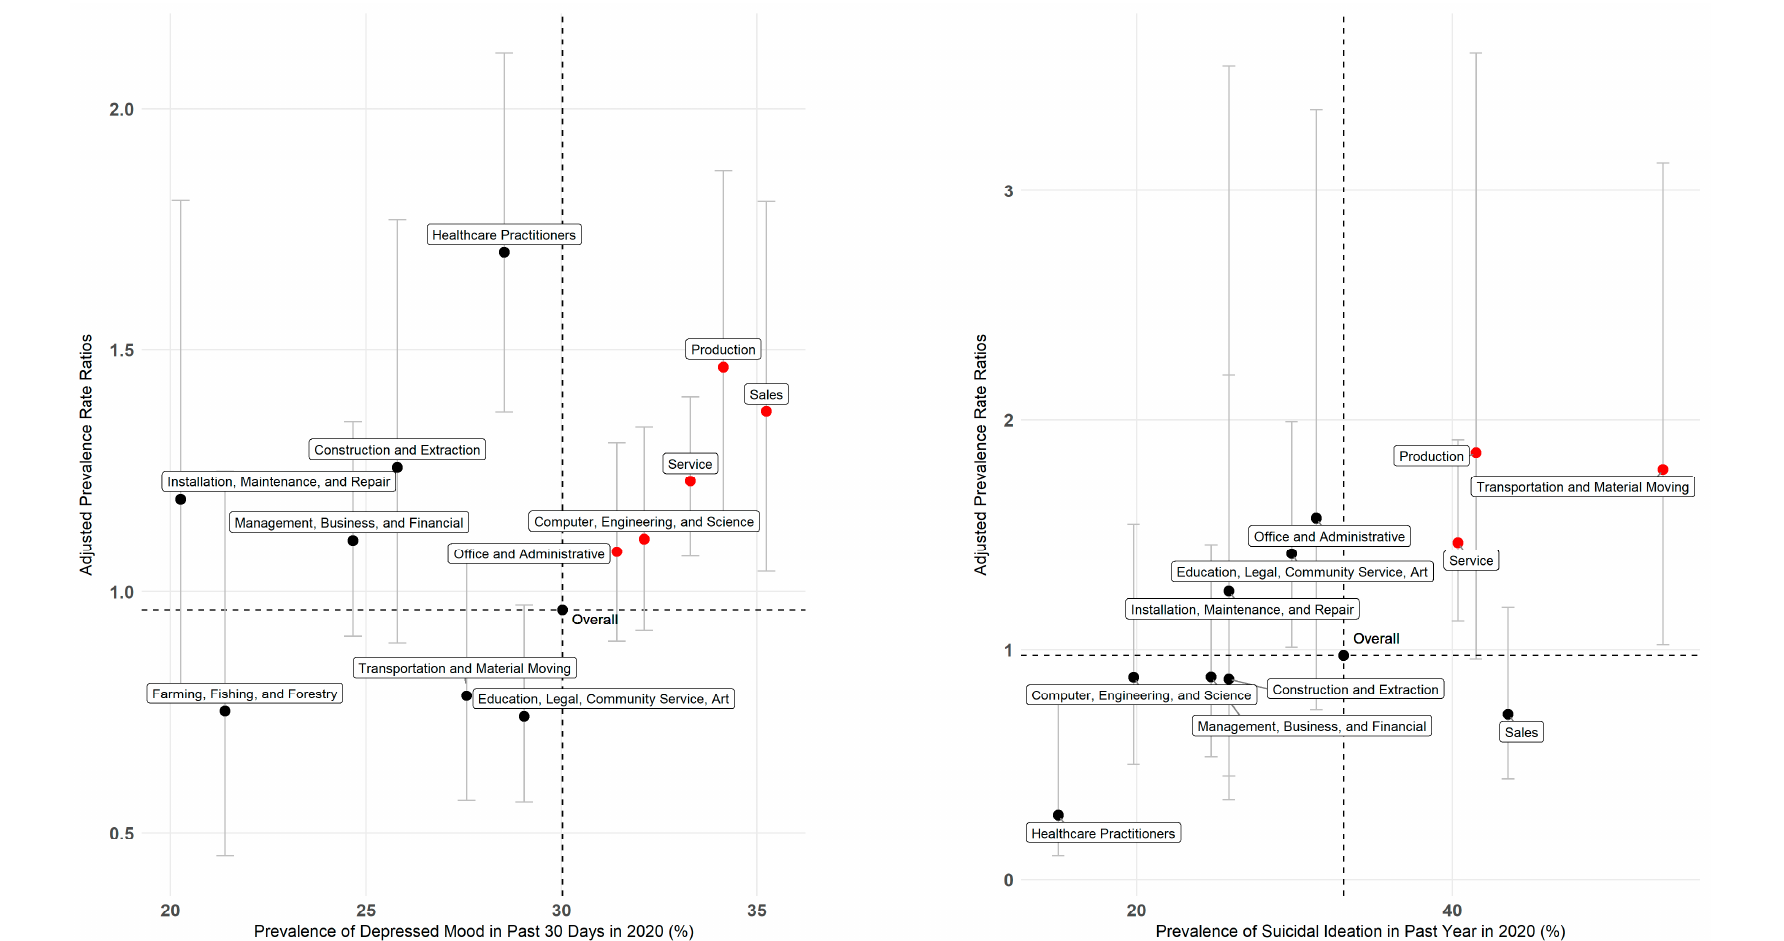
Figure 1. Prevalence in 2020 and adjusted rate ratios for depressed mood among California workers and suicidal ideation in the past year among California workers who have ever thought of suicide.